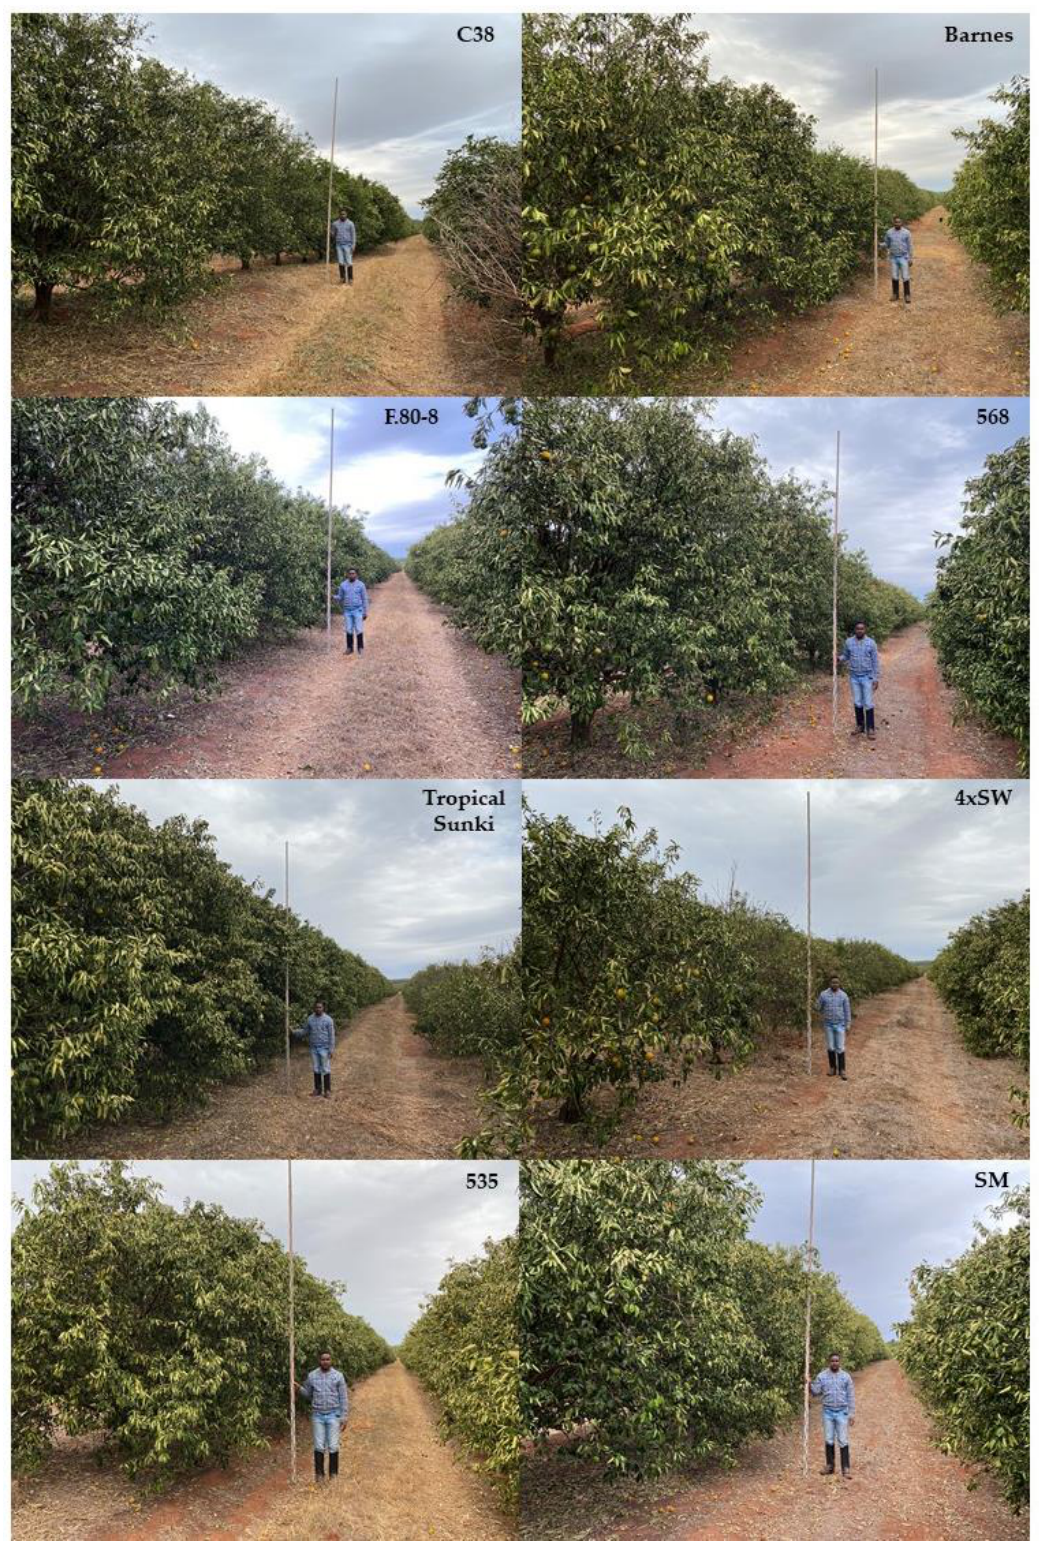
Figure A2. Overall plant stands of Valencia sweet orange ( Citrus × sinensis (L.) Osbeck) grafted onto 23 rootstocks in 2021, 10 years after rainfed cultivation in northwestern São Paulo, Brazil. Rootstock acronyms according to Table 1. SM is Sunki mandarin commercially cultivated at the same block, age and plant care conditions. Tropical Sunki is the control.